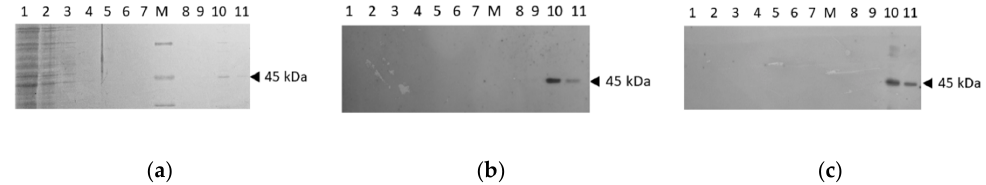
Figure 1. Purification and identification of the recombinant human RFVT2. ( a ) Solubilized bacterial proteins were loaded on a Ni 2+ -chelating chromatographic column. After column washing, RFVT2 was eluted using a buffer containing 0.1% C 12 E 8 , 200 mM NaCl, 10 mM Tris/HCl pH 8.0 and 50mM Imidazole. Fractions of 1 mL were collected and separated by sodium dodecyl sulfate polyacrylamide gel electrophoresis (SDS–PAGE) on 12% polyacrylamide gel and stained with Coomassie Blue. Lane 1 and 2 pass-through fractions, lane 3–7 washing fractions, lane 8–11 elution fractions; ( b ) Immunoblotting of the same samples of (a) using the anti-RFVT2 antibody whit a dilution of 1:2000; ( c ) Immunoblotting of the same samples of (a) using the anti-His antibody whit a dilution of 1:40000. Similar results were obtained in three different experiments .